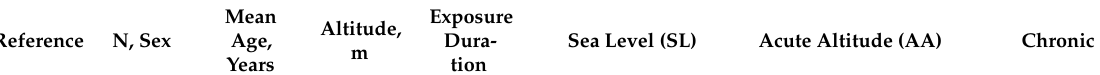
Table 1. Changes of VO 2 max and its determinants in well-trained subjects exposed to acute and chronic high